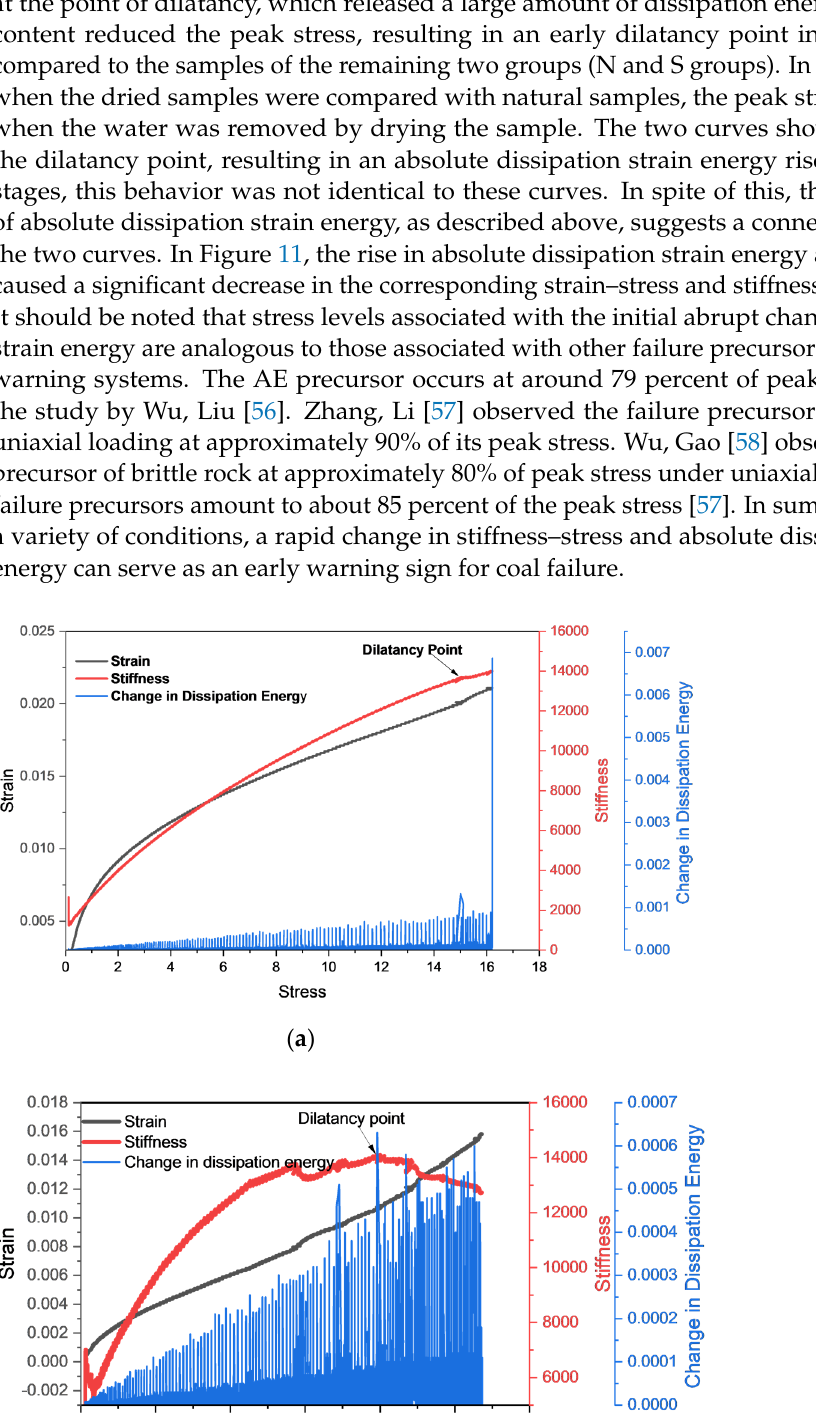
( c ) Figure 11. Relation of strain, stiffness, and change in dissipation energy over the stress of ( a ) dry sample, ( b ) natural sample, and ( c ) saturated sample.